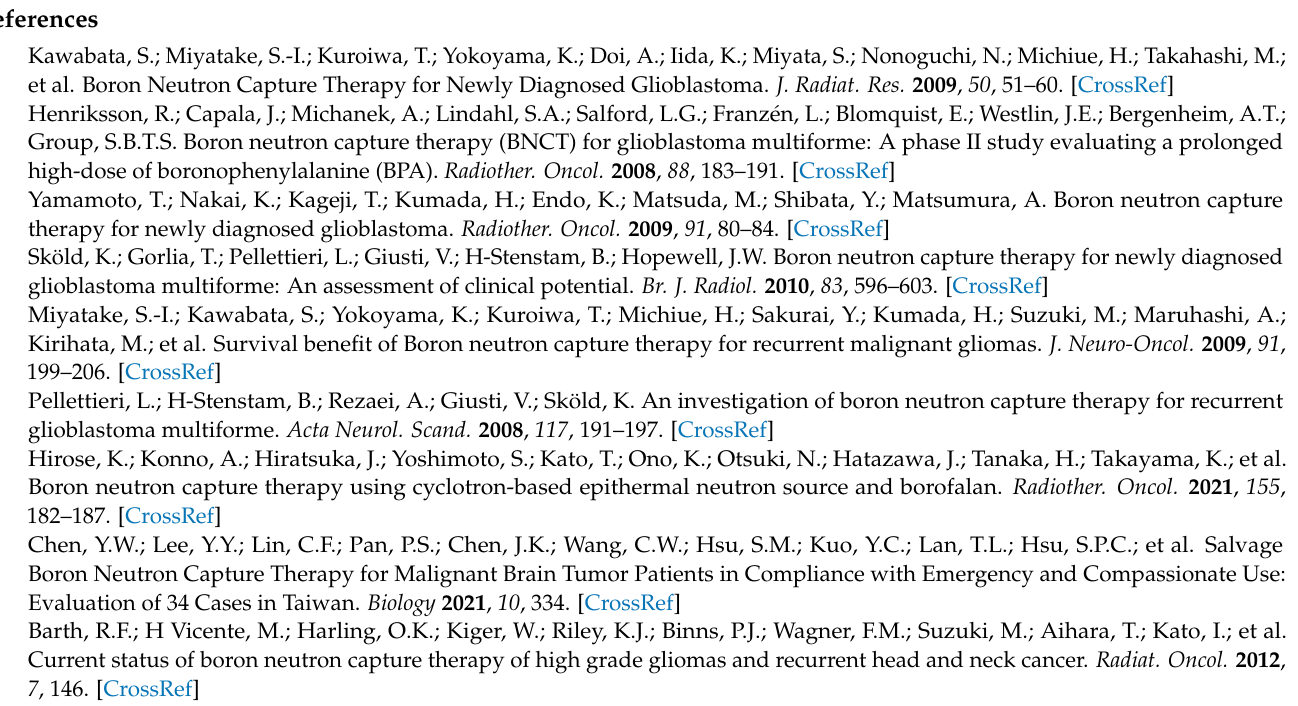
table, and is expressed as the mean boron values ( µ g B/gram: weight of organ) ± standard weight of organ) ± standard deviation.